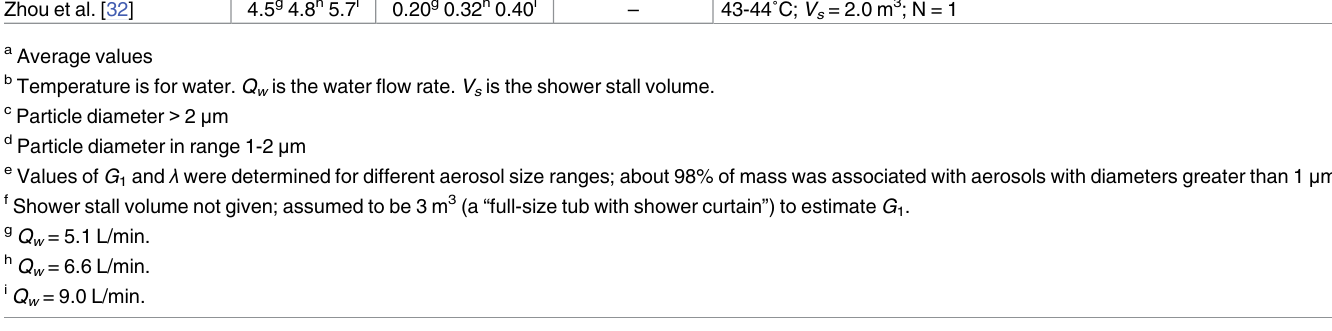
Table 3. Aerosol Mass-generation Rate ( G 1 , mg/min) and Removal Rates ( λ , min -1 ) for Showers. Study G 1 a Xu and Weisel